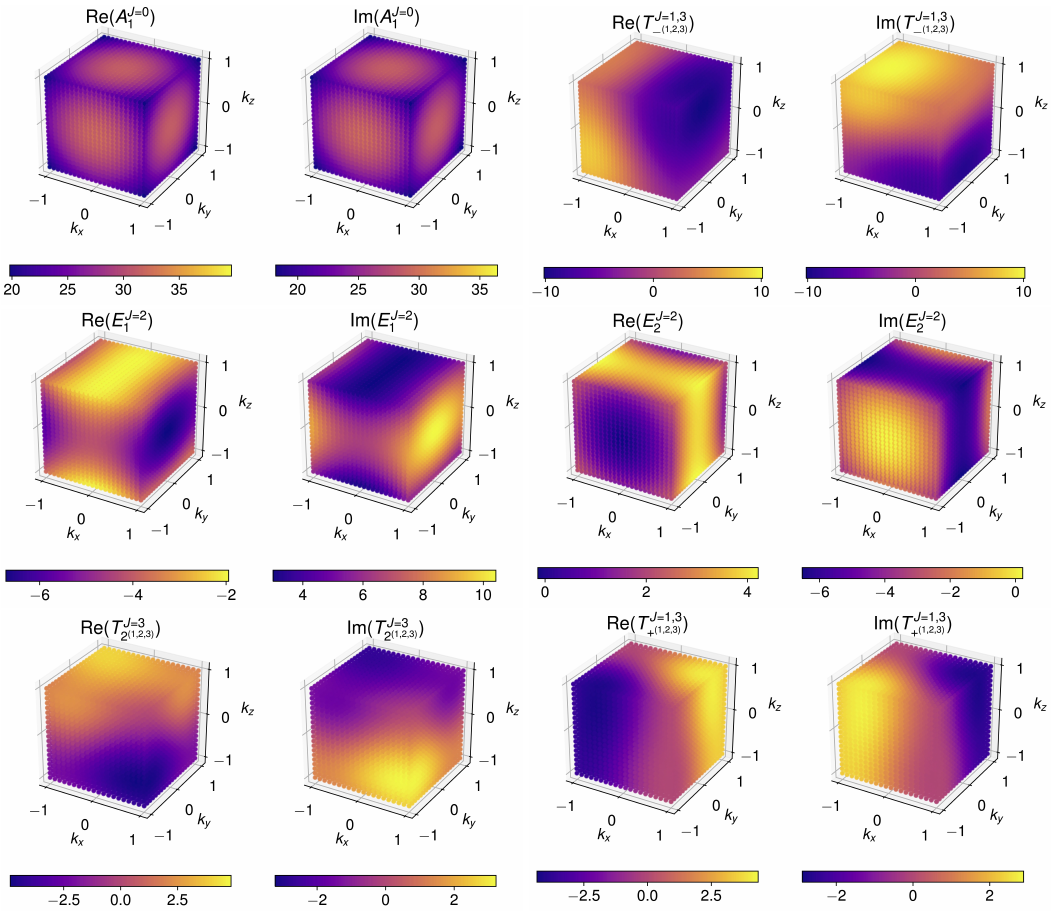
Figure 5: Momentum space distribution of the superconducting states arising from the two-channel Kondo interaction presented in Table 1 and Fig.